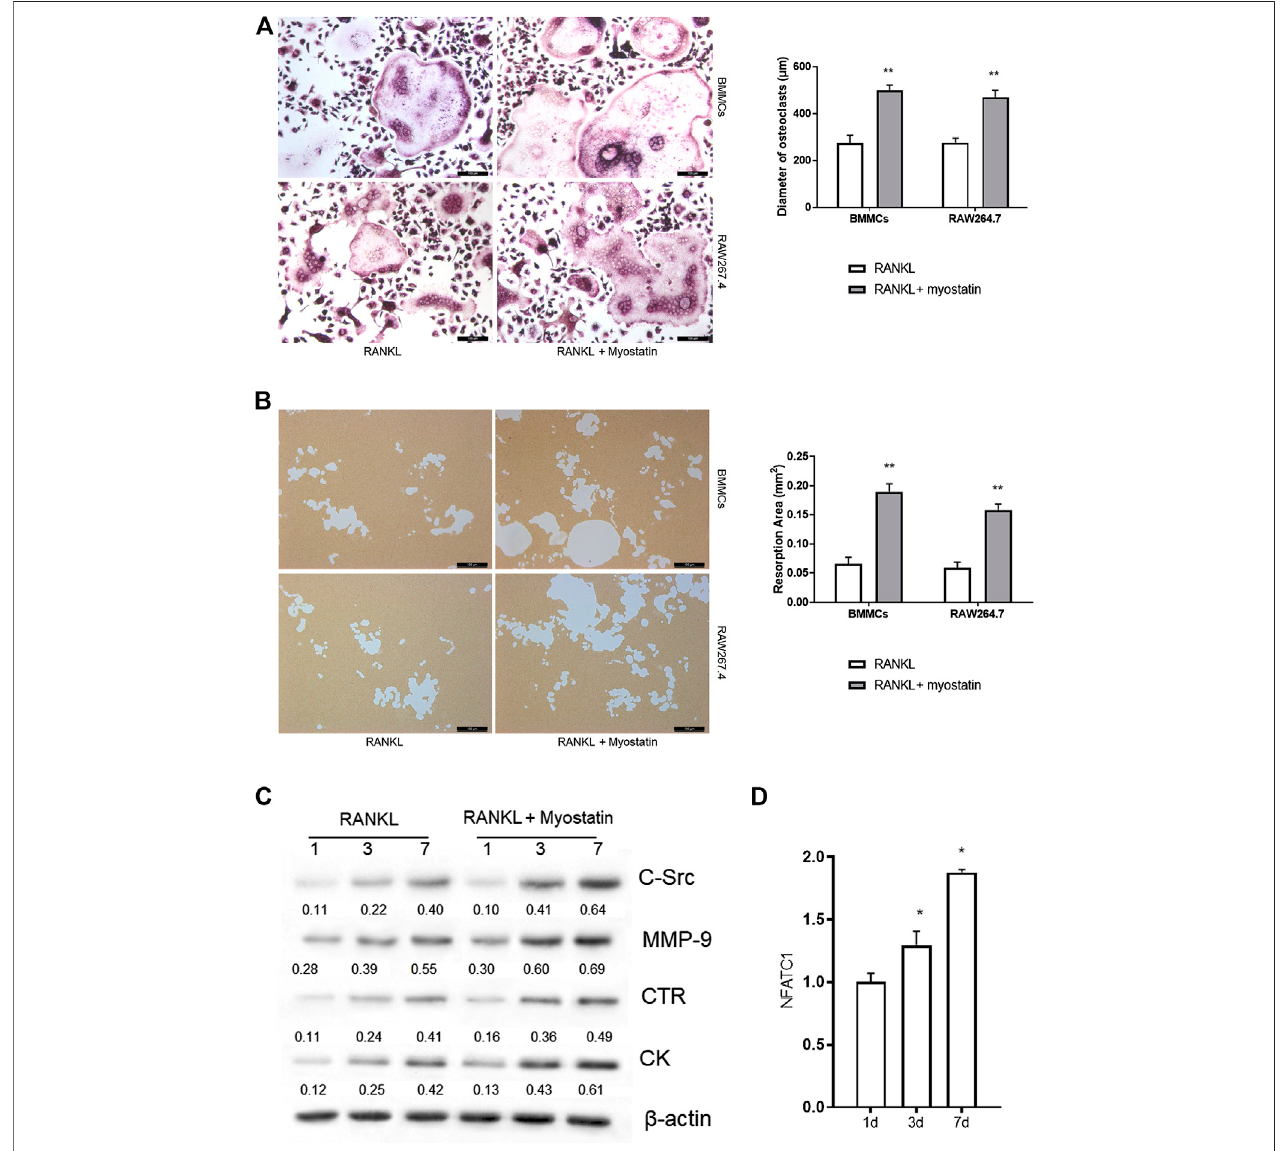
FIGURE 2 | Myostatin promotes osteoclastogenesis and osteoclast function. (A) TRAP staining of osteoclasts (Scalebar, 100 μ m). (B) Representative images of resorption pits localized on biomimetic synthetic bone; the resorptive area was analyzed in the histogram (Scale bar, 100 μ m). (C) Expressions of C-Src, MMP-9, CTR, cathepsin K, and β -actin as analyzed by western blotting. (D) The total RNA of NFATc1 was analyzed by RT-PCR. ** p < 0.01.